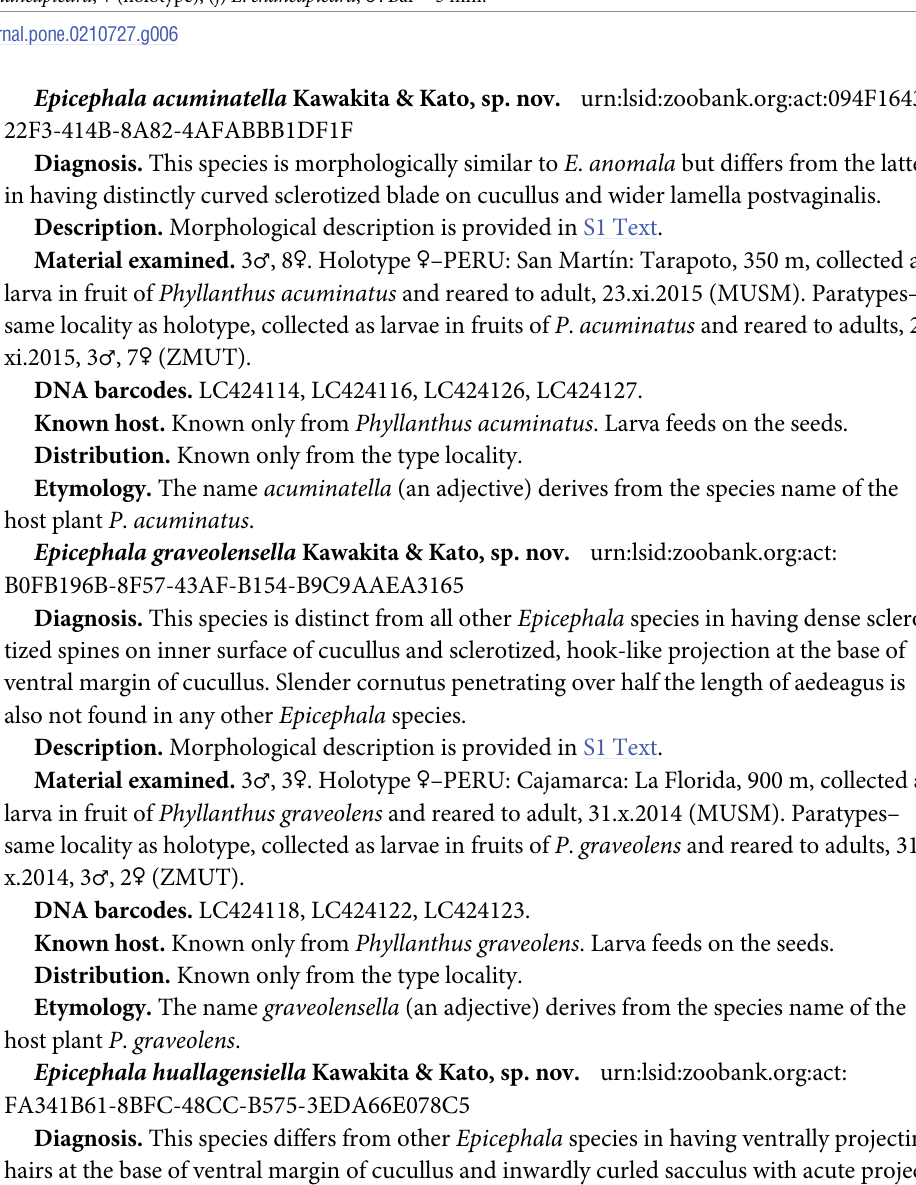
Fig 6. Representative specimens of the five Epicephala species in Peru. (a) E . anomala , ♀ (holotype); (b) E . anomala , ♂ ; (c) E . acuminatella , ♀ (holotype); (d) E . acuminatella , ♂ ; (e) E . graveolensella , ♀ (holotype); (f) E . graveolensella , ♂ ; (g) E . huallagensiella , ♀ (holotype); (h) E . huallagensiella , ♂ ; (i) E . chancapiedra , ♀ (holotype); (j) E . chancapiedra , ♂ . Bar = 5